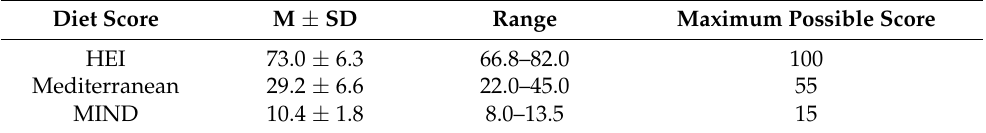
Table 3. PwPs’ diet score results.